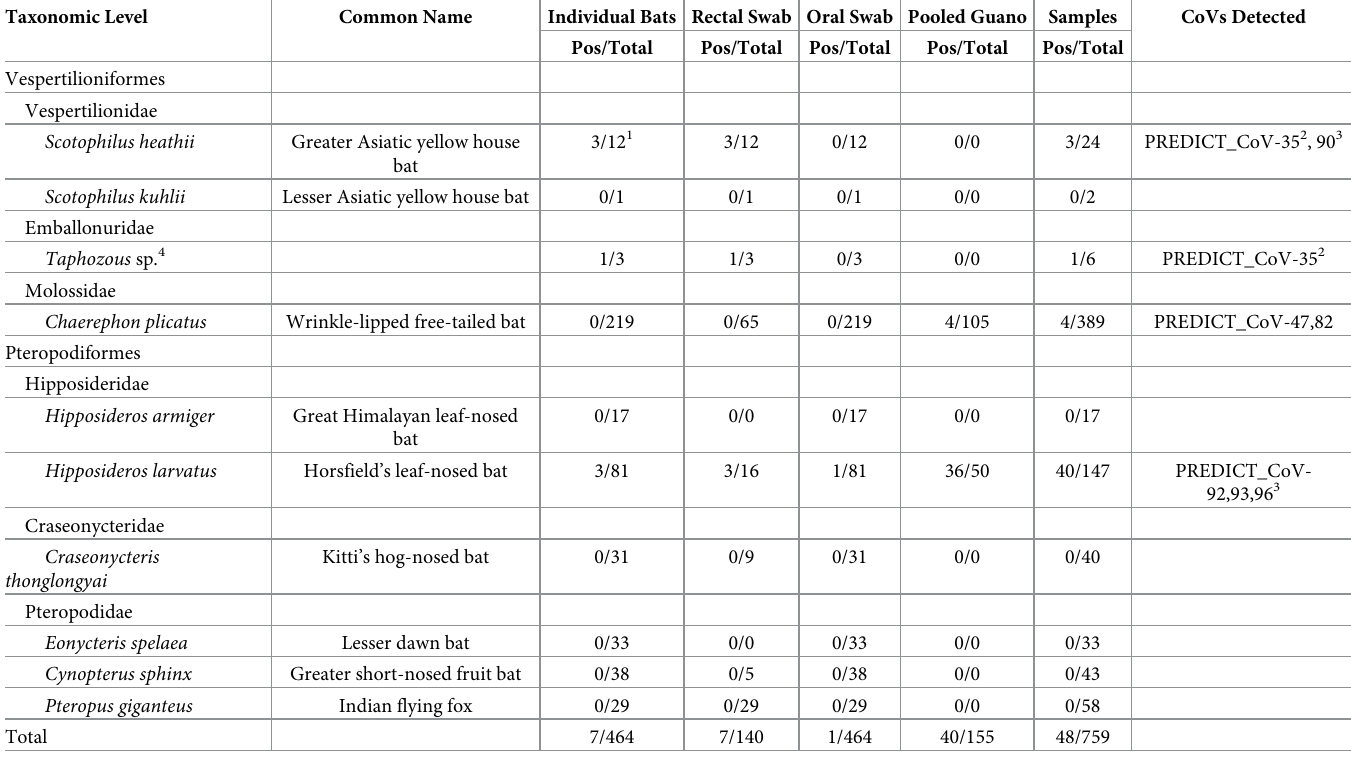
Table 1. Summary of positives and coronaviruses detected in bats in